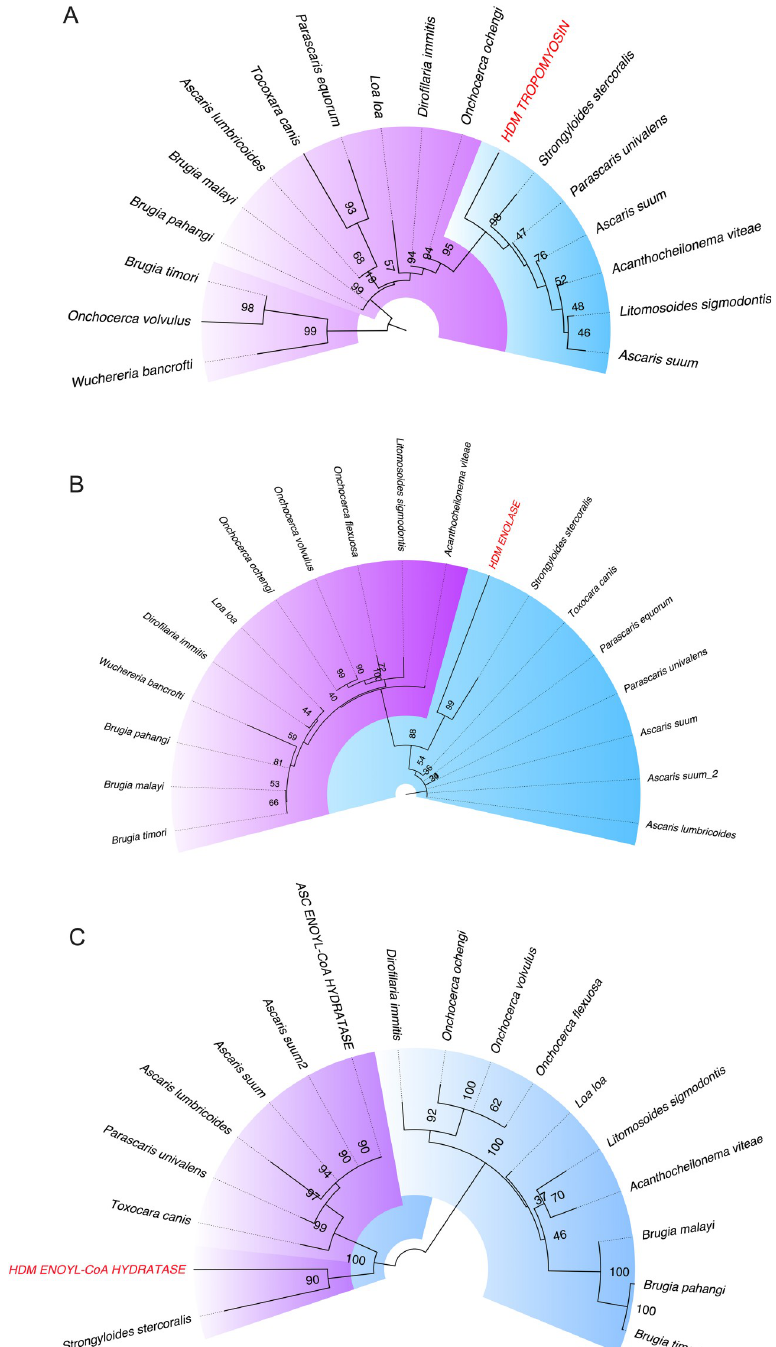
Fig 5. Phylogenetic trees highlighting the evolutionary relationships between house dust mite and helminth proteins. Alignments of tropomyosin (A), enolase (B) and enoyl-CoA-hydratase (C) with their helminth orthologues indicating their level of distance and phylogeny. Different clades are separated by colors. Two different proteomic datasets from Ascaris suum were used for the analysis.